Question: Which visualization type does this figure use?
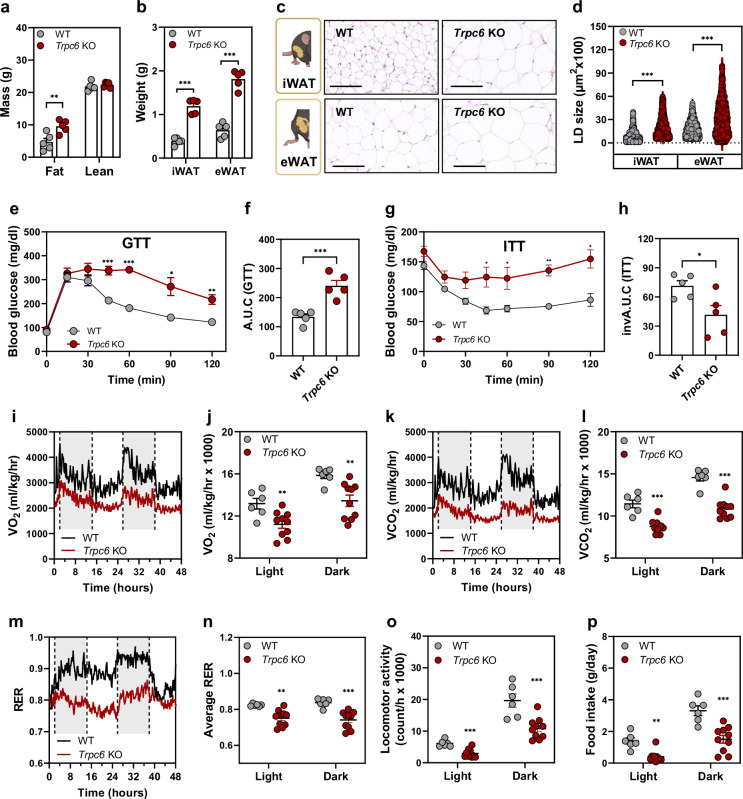
Answer: bar